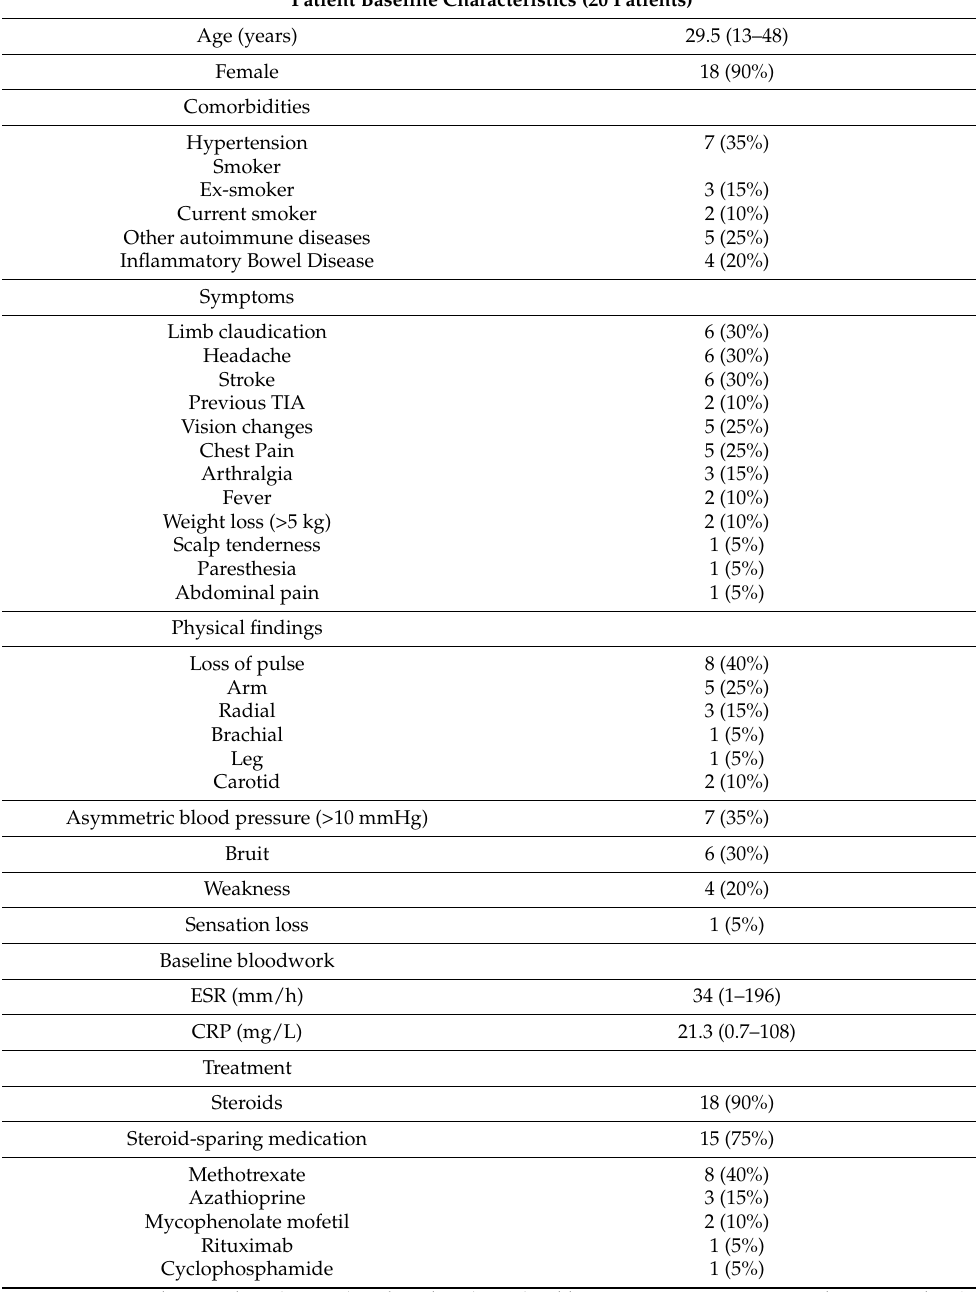
Table 1. Baseline characteristics of TAK